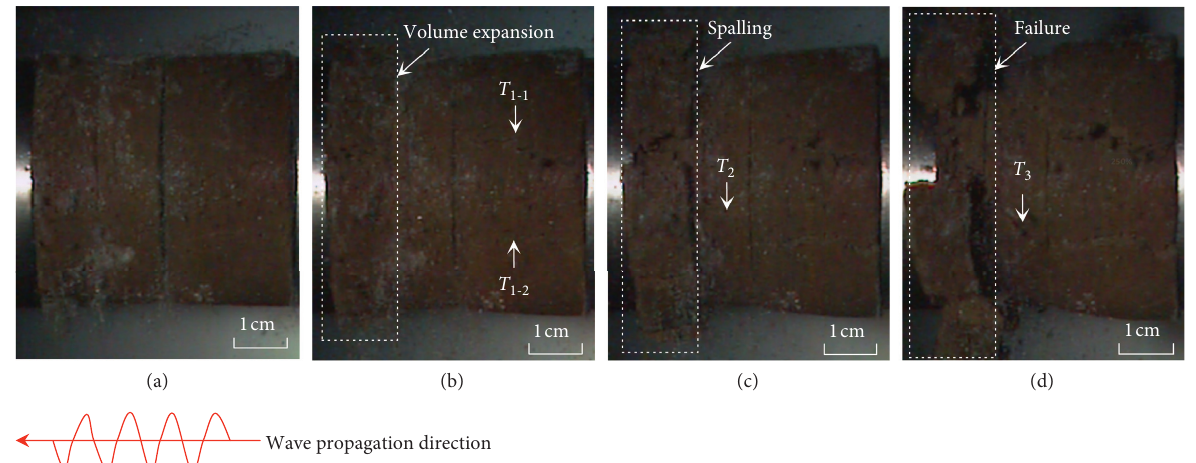
Figure 11: Fracture processes of frozen silty soil specimen with two prefabricated